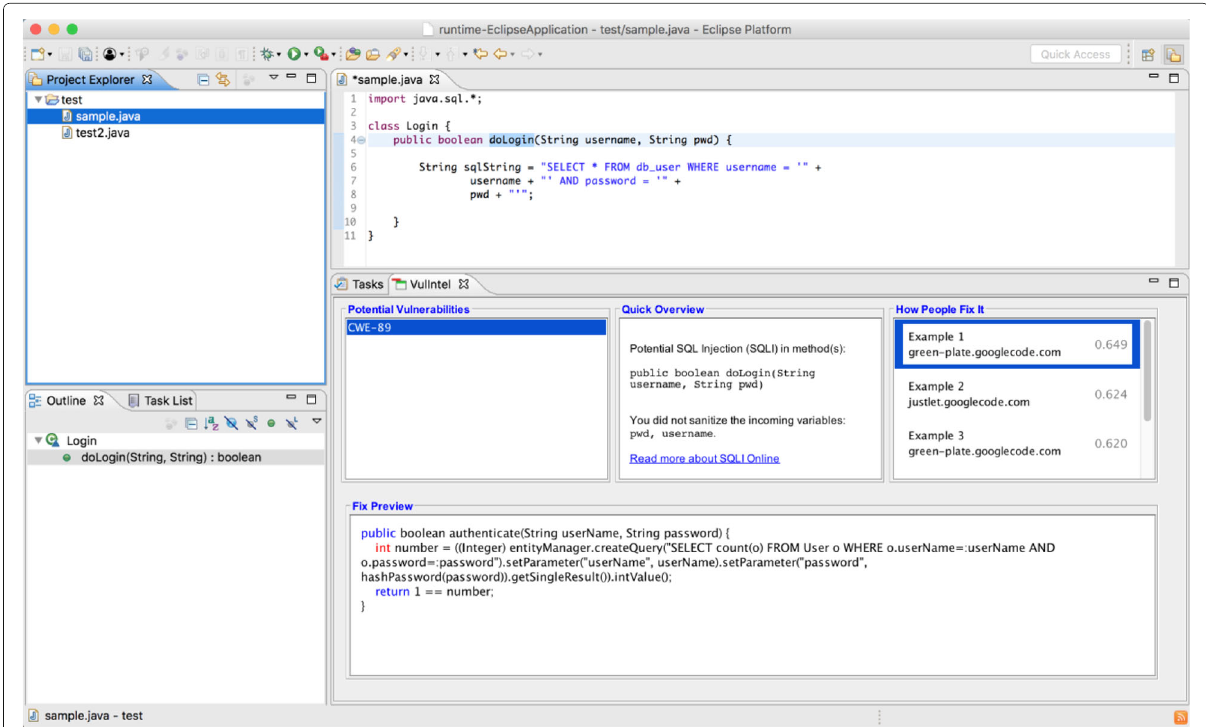
Fig. 8 Screenshot of the final design of the plugin as incorporated in the Eclipse